Question: Express in one sentence what the figure is showing.
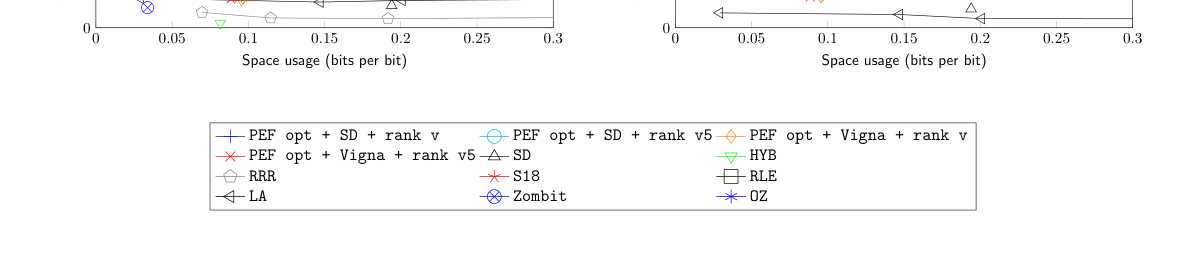
Answer: Experimental space/time trade-offs for different compressed bit vector representations on bit sequences with runs. The bit vectors used in the tests correspond to sequences B0, . . . , Bp−1 using partition approach A4. Results for operation rank are shown in the left column, whereas select is shown in the right column.